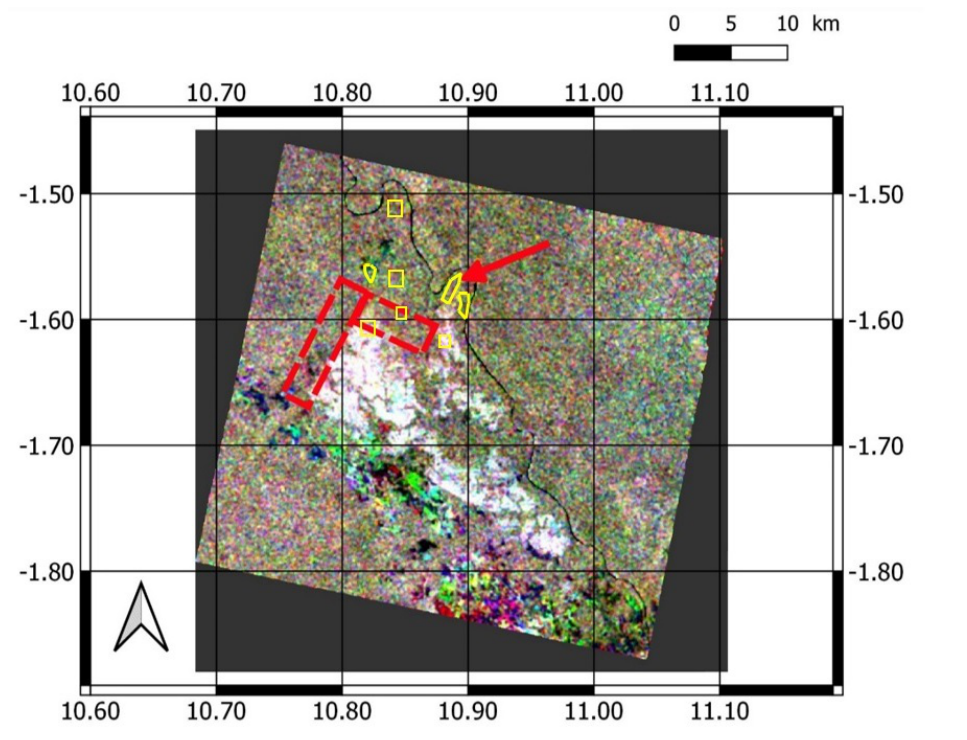
Figure 14. Temporal RGB composition of VV/VH ratio combining 2019 (R), 2020 (G) and 2021 (B) during the wet season. The yellow polygons indicate the areas under